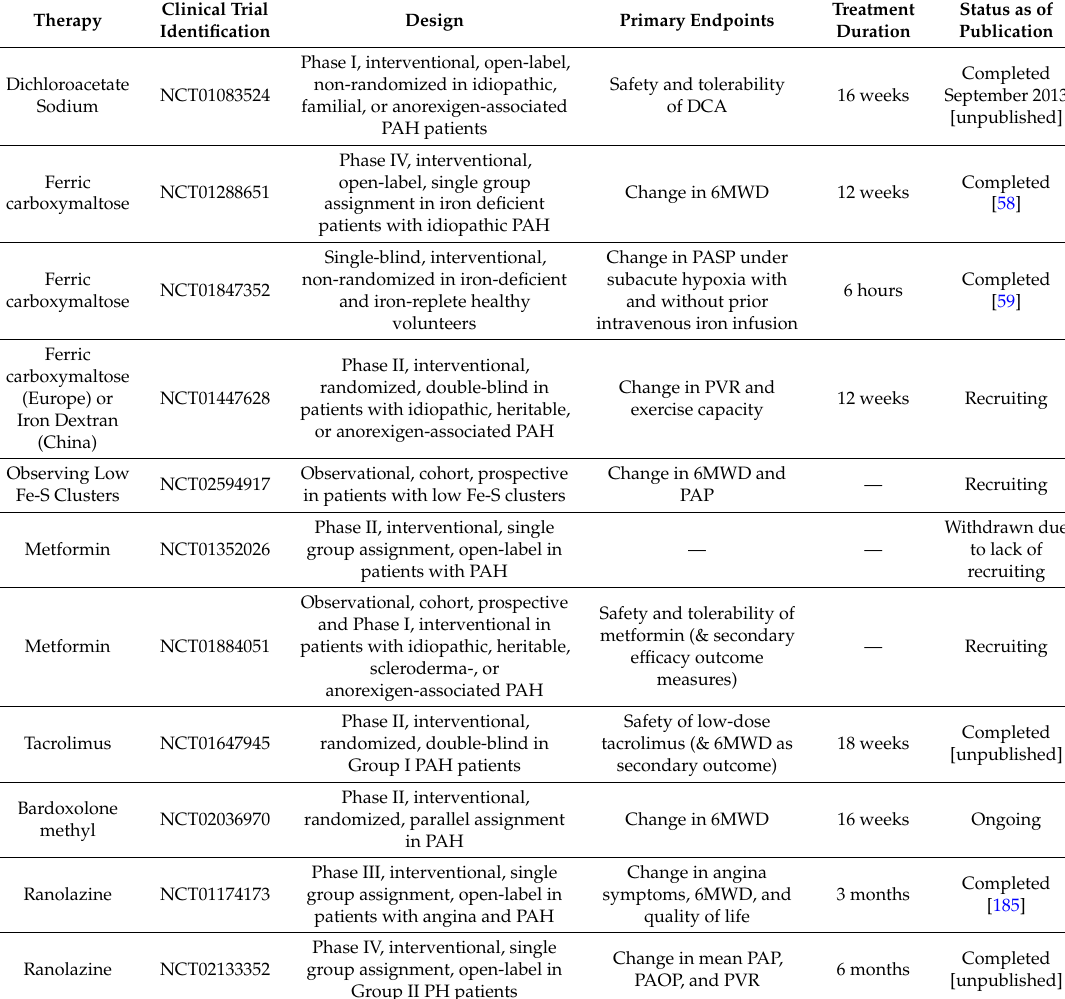
Table 2. Clinical Trials in Pulmonary Hypertension. 6MWD: 6-minute walk distance. DCA: dichloroacetate. 18 FDG: 18F-fluorodeoxyglucose. PAP: pulmonary artery pressure. PAOP: pulmonary artery wedge pressure. PASP: pulmonary artery systolic pressure. PVR: pulmonary vascular resistance. MRI: magnetic resonance imaging. RVEF: right ventricular ejection